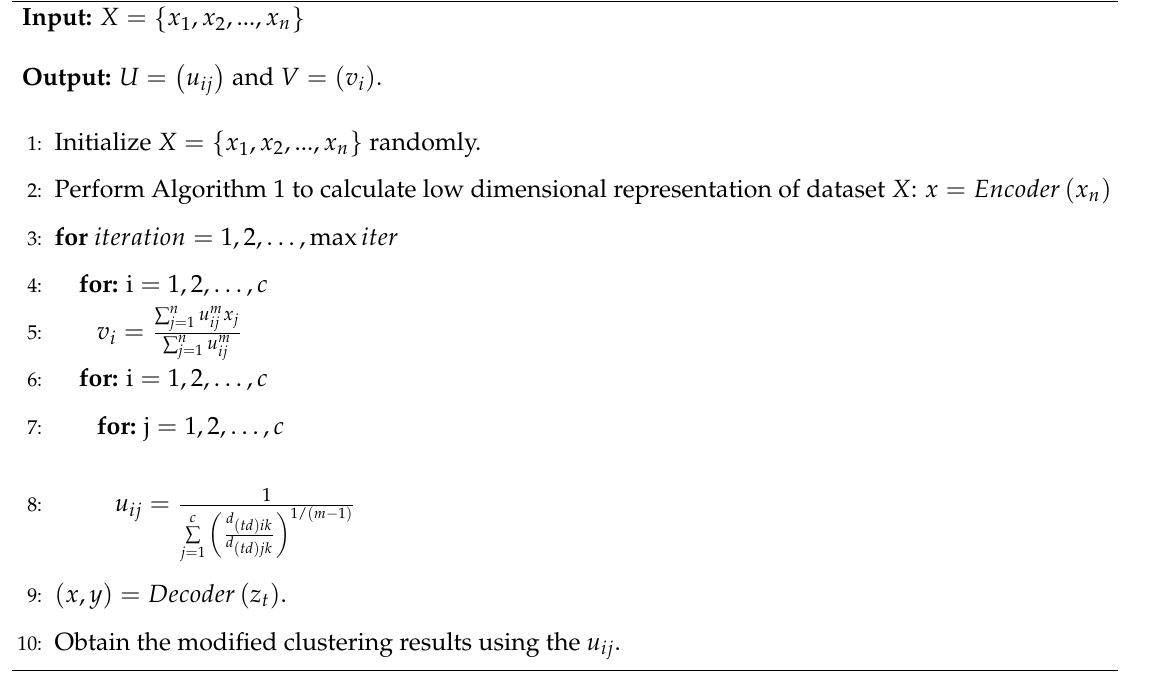
Algorithm 2 The VAE-HOFCM